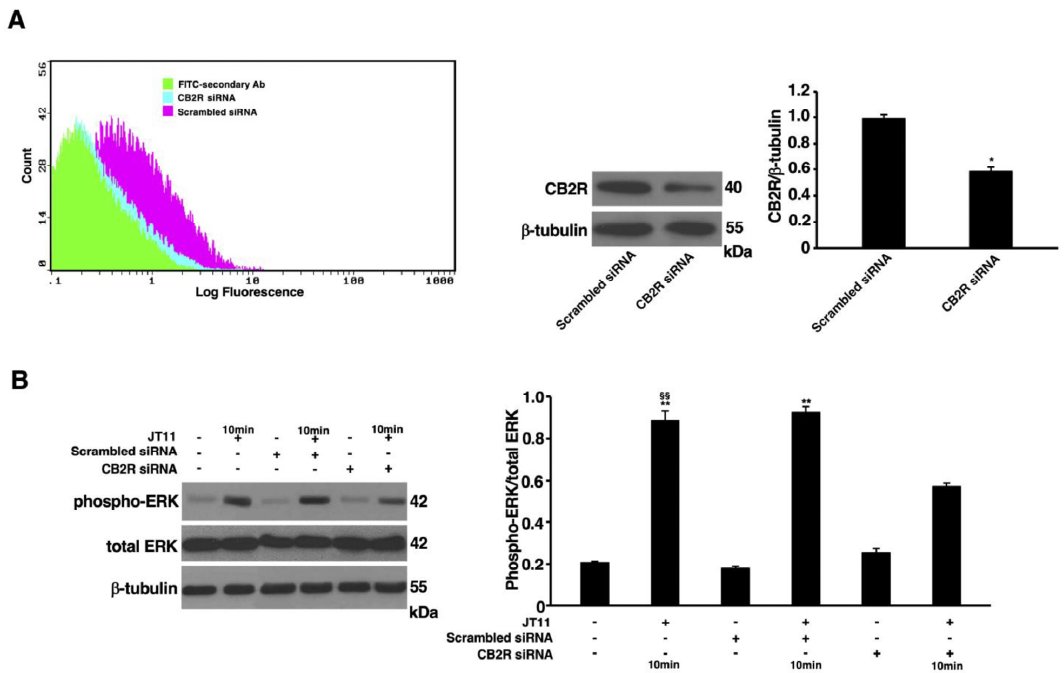
Figure 4. JT11 induces ERK1/2 phosphorylation through a CB2R-dependent mechanism in Jurkat cells. Jurkat cells were transfected with CB2R siRNA or with Scrambled siRNA, and after they were treated with 2 μ M JT11 for 10 min. Evaluation of CB2R expression after 72 h siRNA transfection, where a scrambled siRNA was used as control, by flow cytometric analysis (( A ), left panel) and Western blot analysis. Densitometric CB2R/ β -tubulin ratio is shown. Data are reported as mean ± SD from three independent experiments. * p < 0.01 vs. scrambled siRNA (( A ), right panel). (( B ), left panel) Western blot analysis of the activation (phosphorylation) of extracellular signal-regulated kinase (ERK)1/2. The protein extracts were separated by SDS-PAGE and analyzed using anti-phospho-ERK1/2 and anti-ERK1/2 Abs. The loading control was evaluated using anti- β -tubulin Ab. (( B ), right panel) Densitometric phosphorylated ERK1/2/total ERK1/2 ratio is shown. Data are reported as mean ± SD from three independent experiments. ** p < 0.001 vs. vehicle; §§ p < 0.001 vs. treated, transfected,